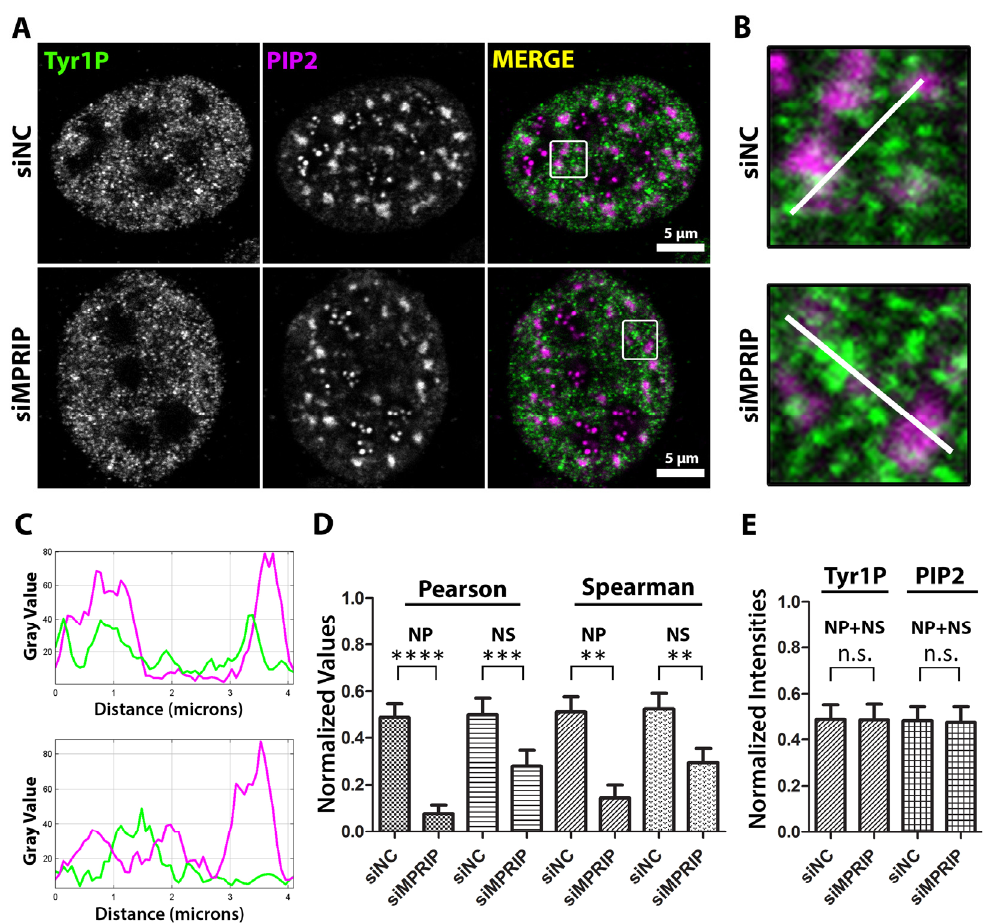
Figure 5. MPRIP depletion leads to the decreased association of Tyr1 phosphorylated RNAPII to PIP2. ( A ) The immunofluorescence experiment visualized by a confocal microscope shows the mutual distribution of PIP2 and Tyr1P-CTD in control and MPRIP depleted U2OS nucleus. Scale bars represent 5 µm. ( B ) Zoomed views of the regions that are marked by a white rectangle in the “merge” images. The white lines on the zoomed views represent the regions of the intensity plots ( C ) where the upper plot corresponds to the intensities of siNC and the lower, to siMPRIP. ( D ) The column chart shows normalized values of Spearman’s and Pearson’s coefficients that are observed in different PIP2-rich nuclear compartments. ( E ) The integrated densities of Tyr1P-CTD and PIP2 signals are normalized and represented as a column chart in control ( siNC —small interfering Negative Control RNAs) and MPRIP depleted ( siMPRIP —small interfering MPRIP RNAs) conditions. NP —Nucleoplasmic, NS —Nuclear Speckles. n.s. —Not significant. The double asterisks “ ** ” correspond to a significance level of p ≤ 0.01, the triple asterisks “ *** ” correspond to a significance level of p ≤ 0.001, and the quadruple asterisks “ **** ” correspond to a significance level of p ≤ 0.0001. n = 2, 10 cells/condition.